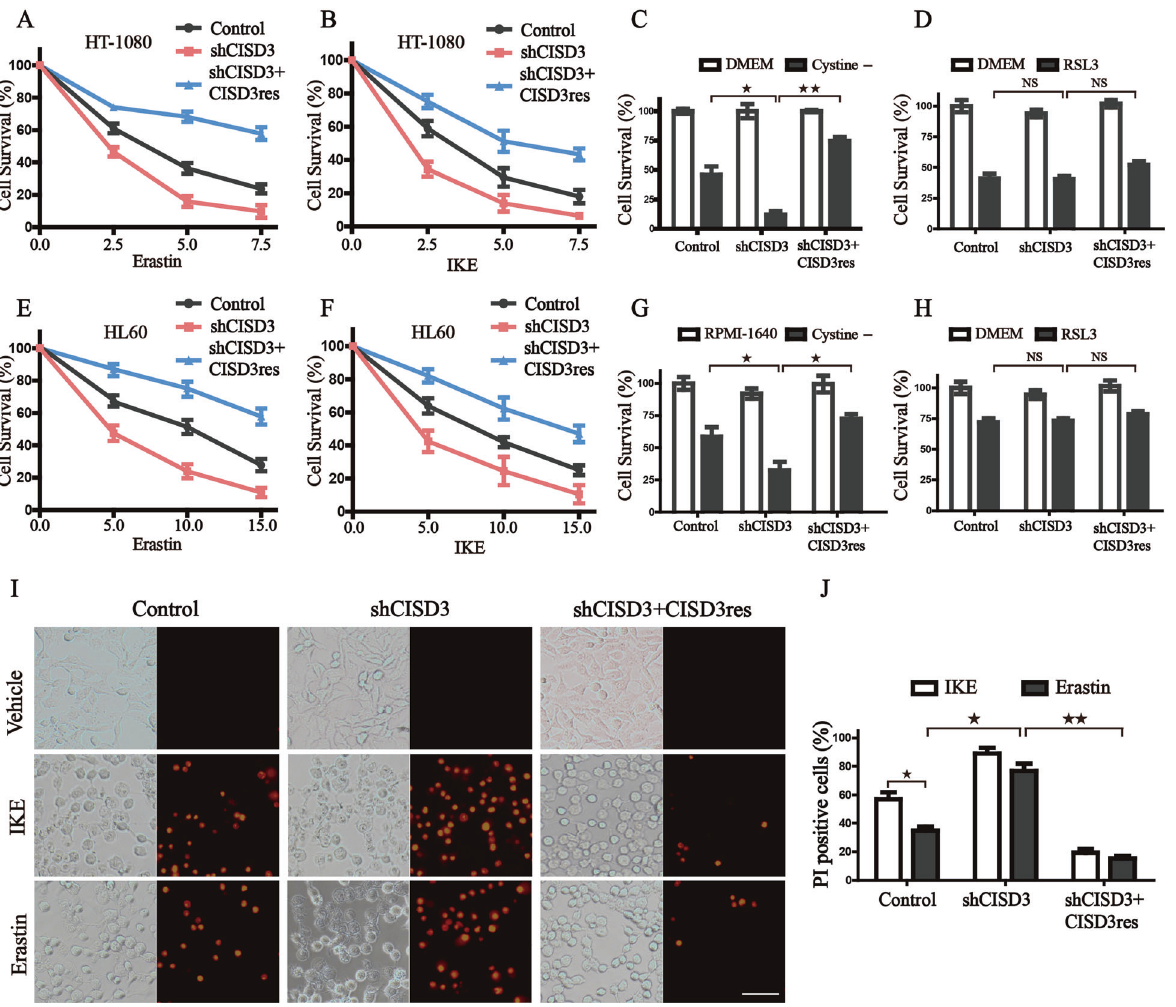
CCK8 assay. Cell survival of HL-60 cells with different CISD3 expression was measured after exposure to indicated concentrations of erastin ( E ) and IKE ( F ) for 12 h, cystine-free media ( G ) for 24 h, or 0.1 μ M RSL3 ( H ) for 12 h. I, J Indicated cells were exposed to 5 μ M IKE or erastin for 12 h and subjected to PI staining. The images were captured by fl uorescent microscopy and PI-positive cells were analyzed using Image J software. The scale bar in the cell image indicates 50 µm. The values are presented as means ± SD from three independent experiments. * P < 0.05 , ** P < 0.01 versus control or between different groups with altered CISD3